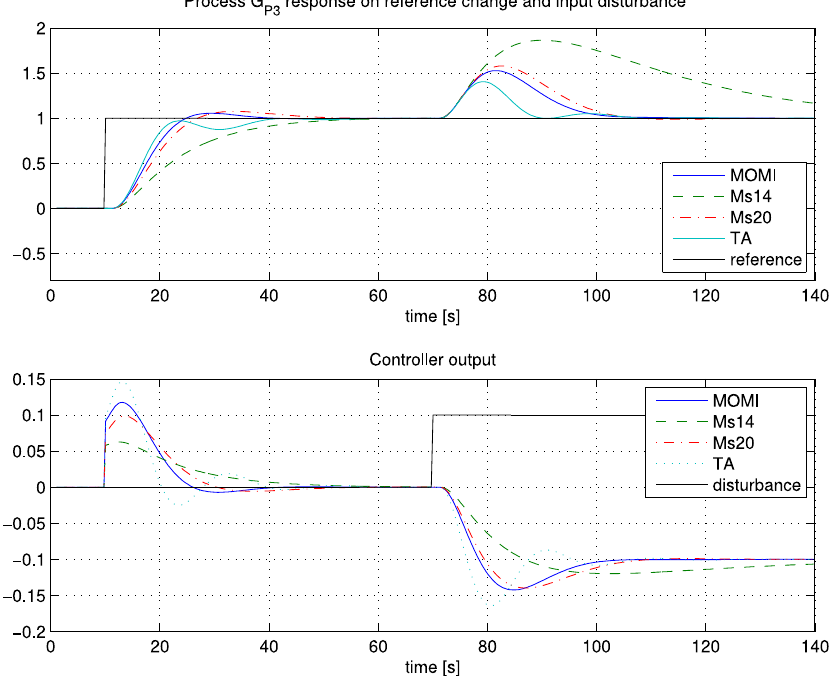
Figure 15. Closed-loop responses of G P3 process. PI controllers were tuned by MOMI, Ms14, Ms20, and TA